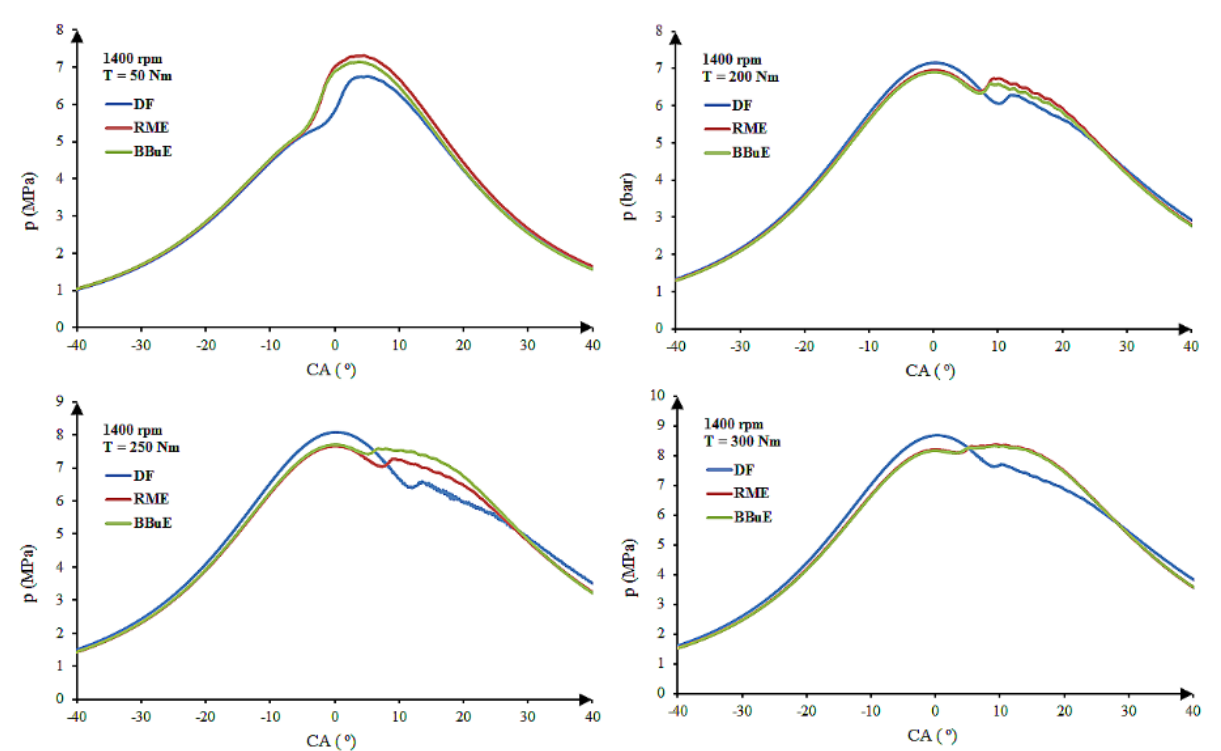
Figure 4. Examples of pressure profiles during the combustion of the tested fuels in the engine cylinder at its operation according to load characteristics.